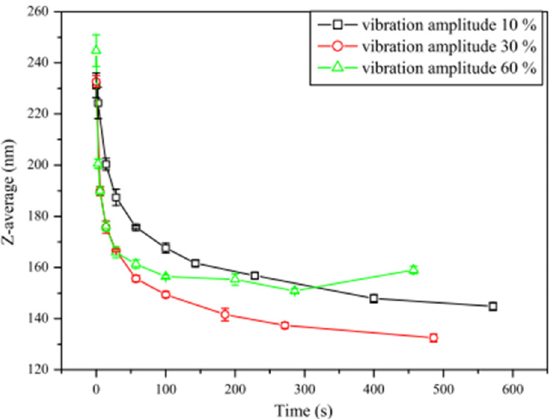
Figure 18. Effect of sonication time (pulse ratio 0.1/2.0 (s/s)) on average cluster size of alumina NF at different vibration amplitudes. Adapted from [179]. at different vibration amplitudes. Adapted from